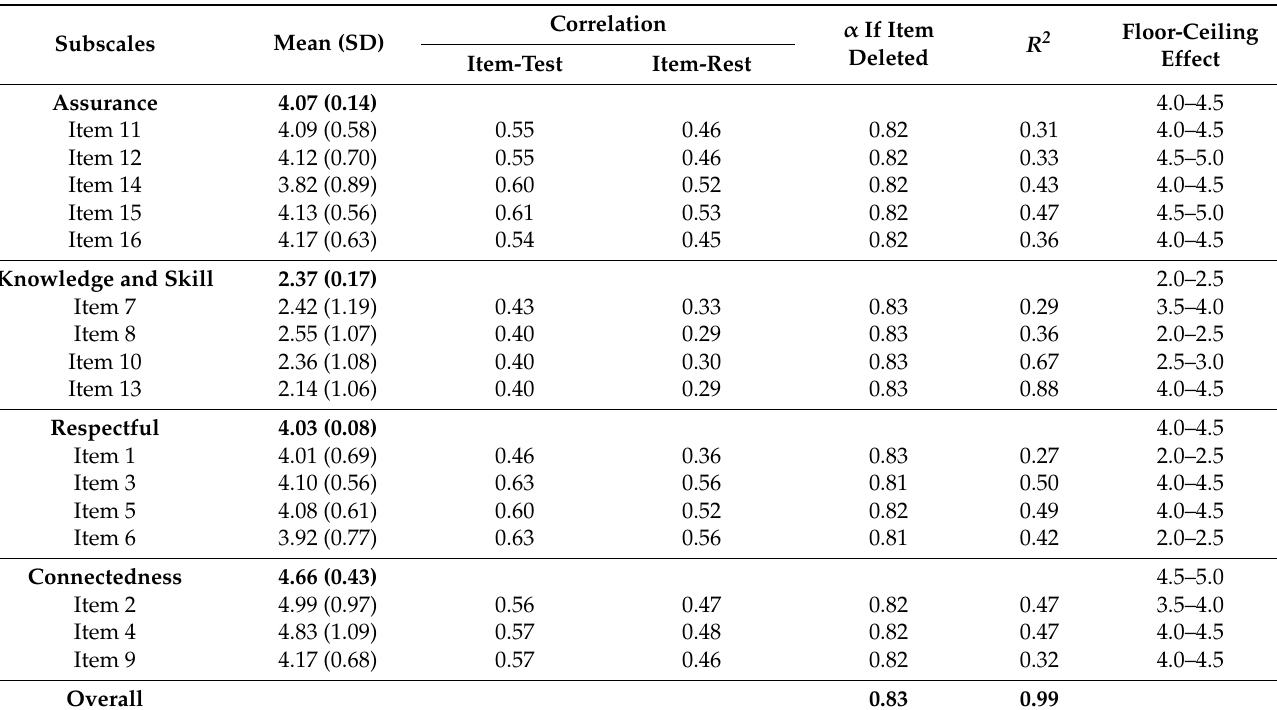
Table 2. Descriptive statistics of the Caring Behaviors Inventory-16 ( n =